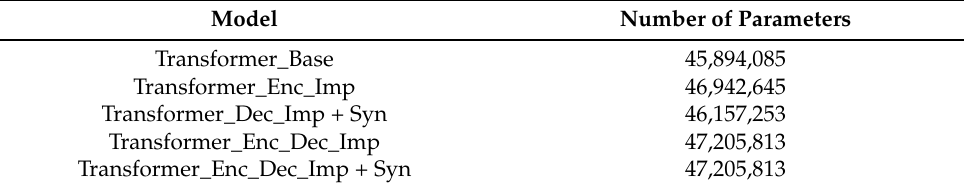
Table 4. The number of parameters for each five-layer model.